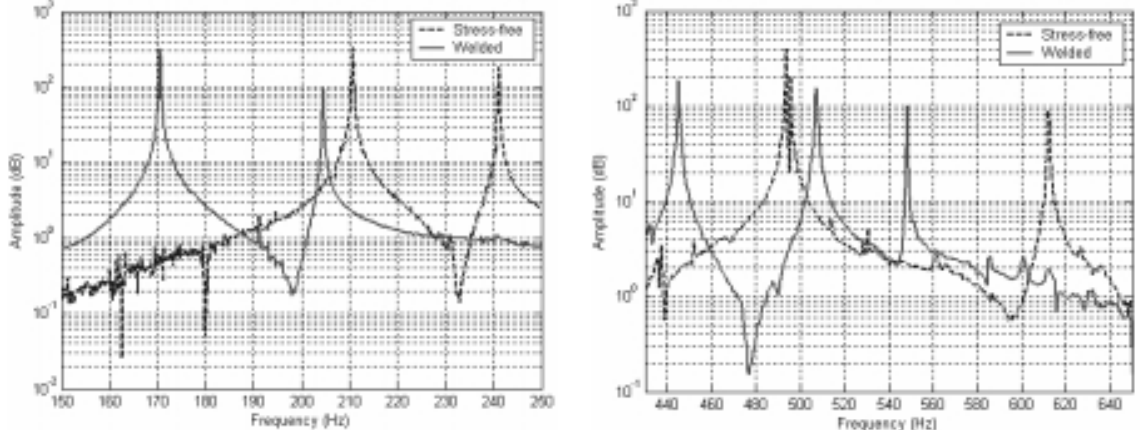
Fig. 6. Amplitudes of a driving-point FRFs of the stress-free and welded conditions.